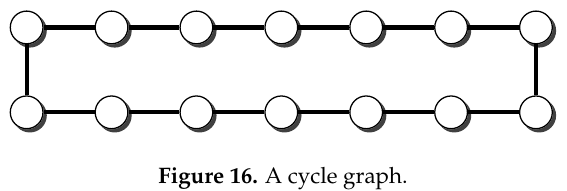
Figure 16. A cycle graph. Figure 18: A cycle graph.